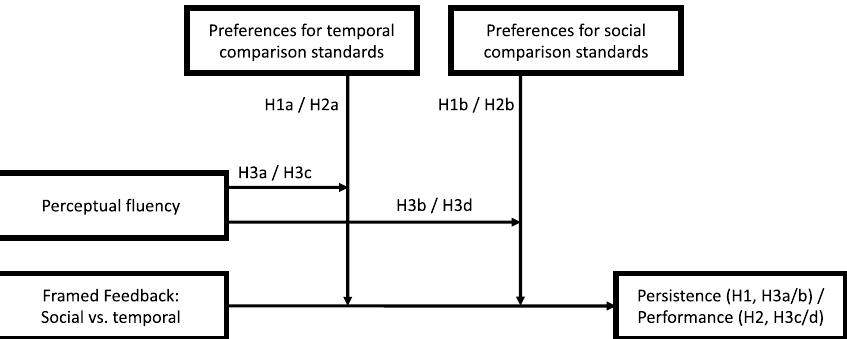
Fig. 1 Conceptual model of fit effects of preferences for comparison standards and feedback with temporal or social comparison standards in dependency of perceptual fluency. The conceptual model is analogous for both outcomes (persistence and performance) investigated in this